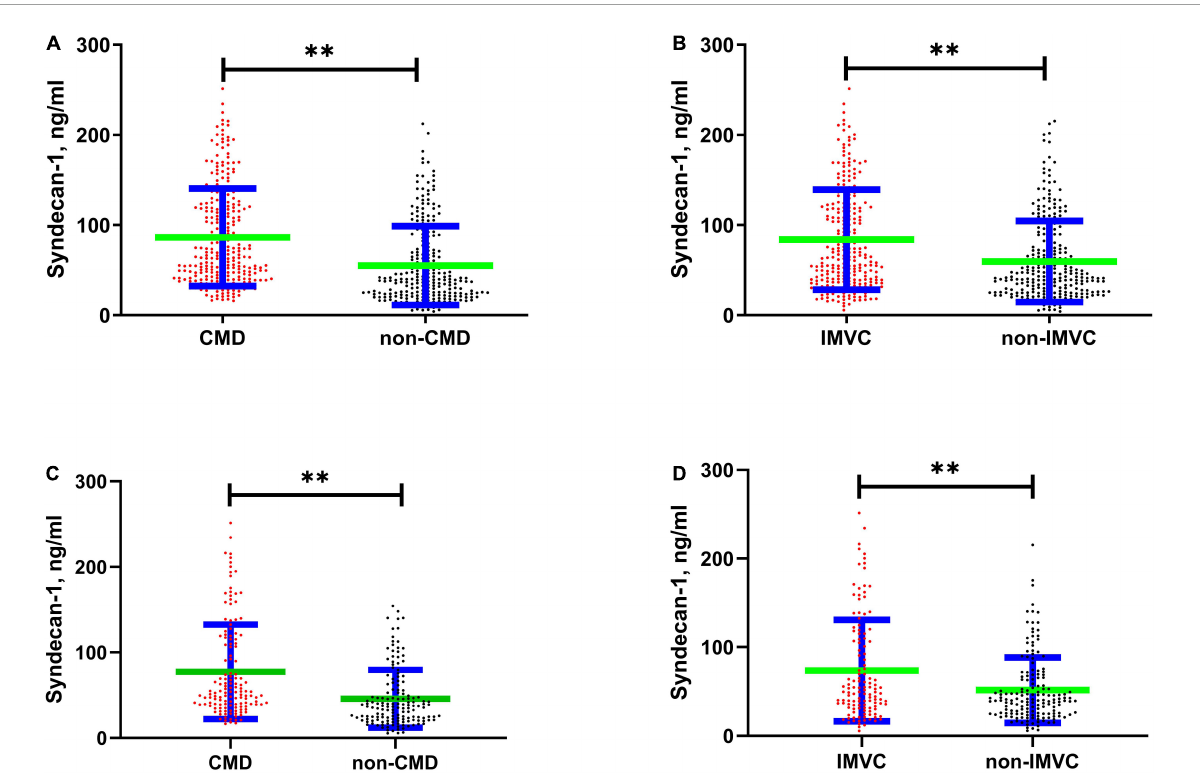
FIGURE2 Scatter Plot showed difference in serum syndecan-1 concentration between different groups. The green horizontal line reflects the average value, and the blue horizontal line reflects the standard error. (A) Shows the difference between CMD and non-CMD (86.44 ± 54.15 vs. 55.2 ± 43.72, P < 0.01). (B) Shows the difference between IMVC and non-IMVC (83.86 ± 55.41 vs. 59.68 ± 45.06, P < 0.01). (C) Shows the difference between CMD and non-CMD among patients without diabetes mellites (77.36 ± 55.27 vs. 45.9 ± 33.79, P < 0.01). (D) Shows the difference between IMVC and non-IMVC among patients without diabetes mellites (IMVC vs. non-IMVC: 73.58 ± 57.23 vs. 51.51 ± 36.92, P < 0.01). CMD, coronary microvascular dysfunction; IMVC, impaired microvascular vasodilatory capacity. ** P < 0.01.